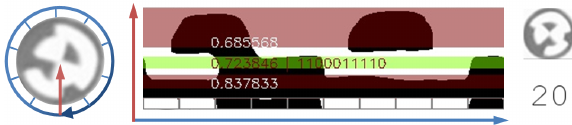
Figure 5: Histogram for an unrolled circular marker and rotation invariant binning of the code stripe. The numbers from top to bottom indicate the probabilities for center, binary code and outer circle. The marker with ID 20 has been successfully decoded.